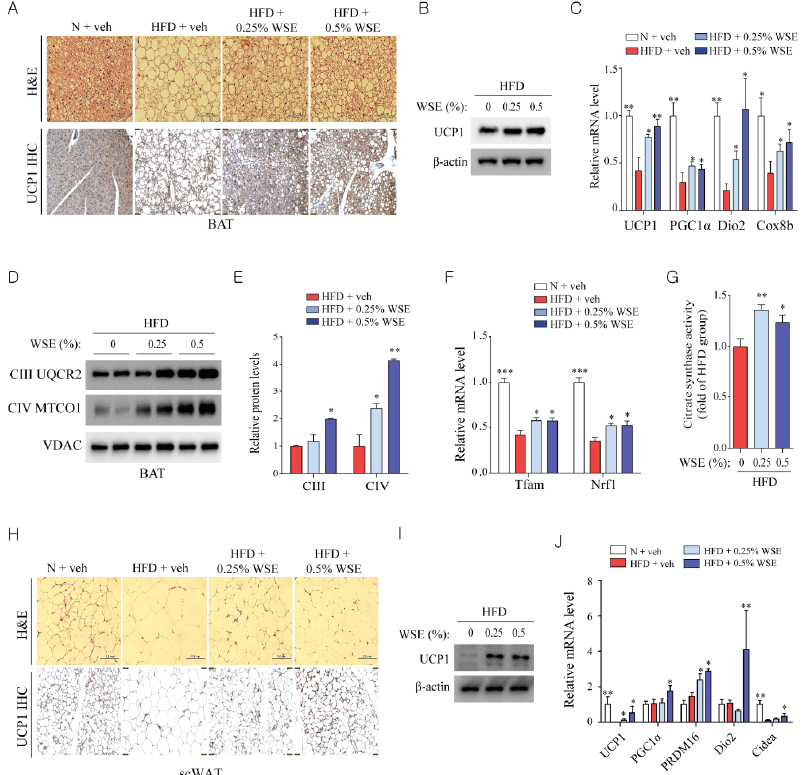
Figure 2. WSE enhances the mitochondrial function of brown adipose tissue (BAT) and the browning of subcutaneous adipose tissue (scWAT) in HFD-fed mice. ( A ) H&E staining and immunohistochemistry for the quantification of UCP1 (uncoupling protein 1) in BAT. ( B ) Protein expression of UCP1 in BAT. ( C ) Relative mRNA expression of BAT-specific genes ( n = 5). ( D ) Expression of proteins involved in mitochondrial complexes III and IV in BAT. The subunits of mitochondrial complexes were detected using the total OXPHOS (oxidative phosphorylation) complex antibody cocktail. ( E ) Densitometry-based quantification data in ( D ), normalized to the level of VDAC (voltage-dependent anion channel). ( F ) Relative mRNA levels of the mitochondrial biogenesis-related genes, Tfam and Nrf1 ( n = 5). ( G ) Citrate synthase activity in BAT ( n = 5). ( H ) H&E staining and immunohistochemistry for quantification of UCP1 expression in scWAT. ( I ) Protein levels of UCP1 in scWAT. ( J ) mRNA expression of BAT-specific genes in scWAT ( n = 5). Data represent the mean ± SEM. Difference between groups was evaluated by Tukey’s multiple comparison test. * p < 0.05; ** p < 0.01; *** p < 0.001 compared with the HFD group.